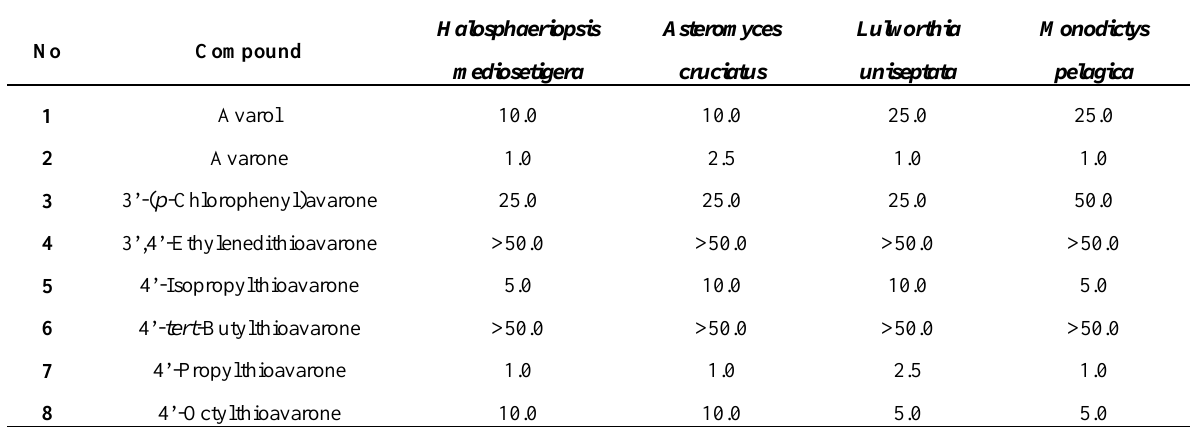
Table 2. Evaluation of antifungal activity (MIC,